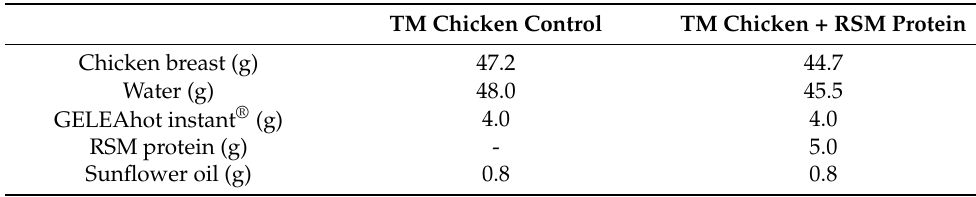
Table 2. Recipe of texture-modified (TM) chicken breast without (control) and with the addition of RSM protein isolate. Values are expressed as g 100 g − 1 of fresh product.